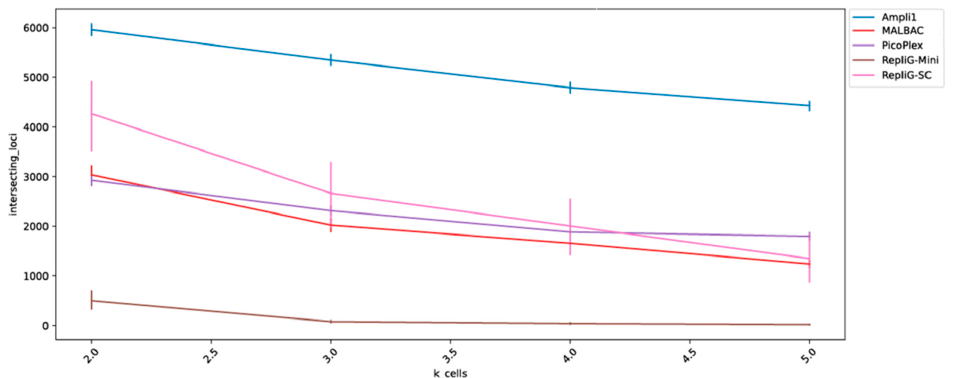
Figure 4. Loci consistently sampled in k cells (higher is better)—the number of intersecting loci is depicted on the Y axis for cell groups of 2–5 cells (X-axis). All samples were virtually sampled with 100,000 mapped reads and kits with less than 5 cells with at least that many reads were